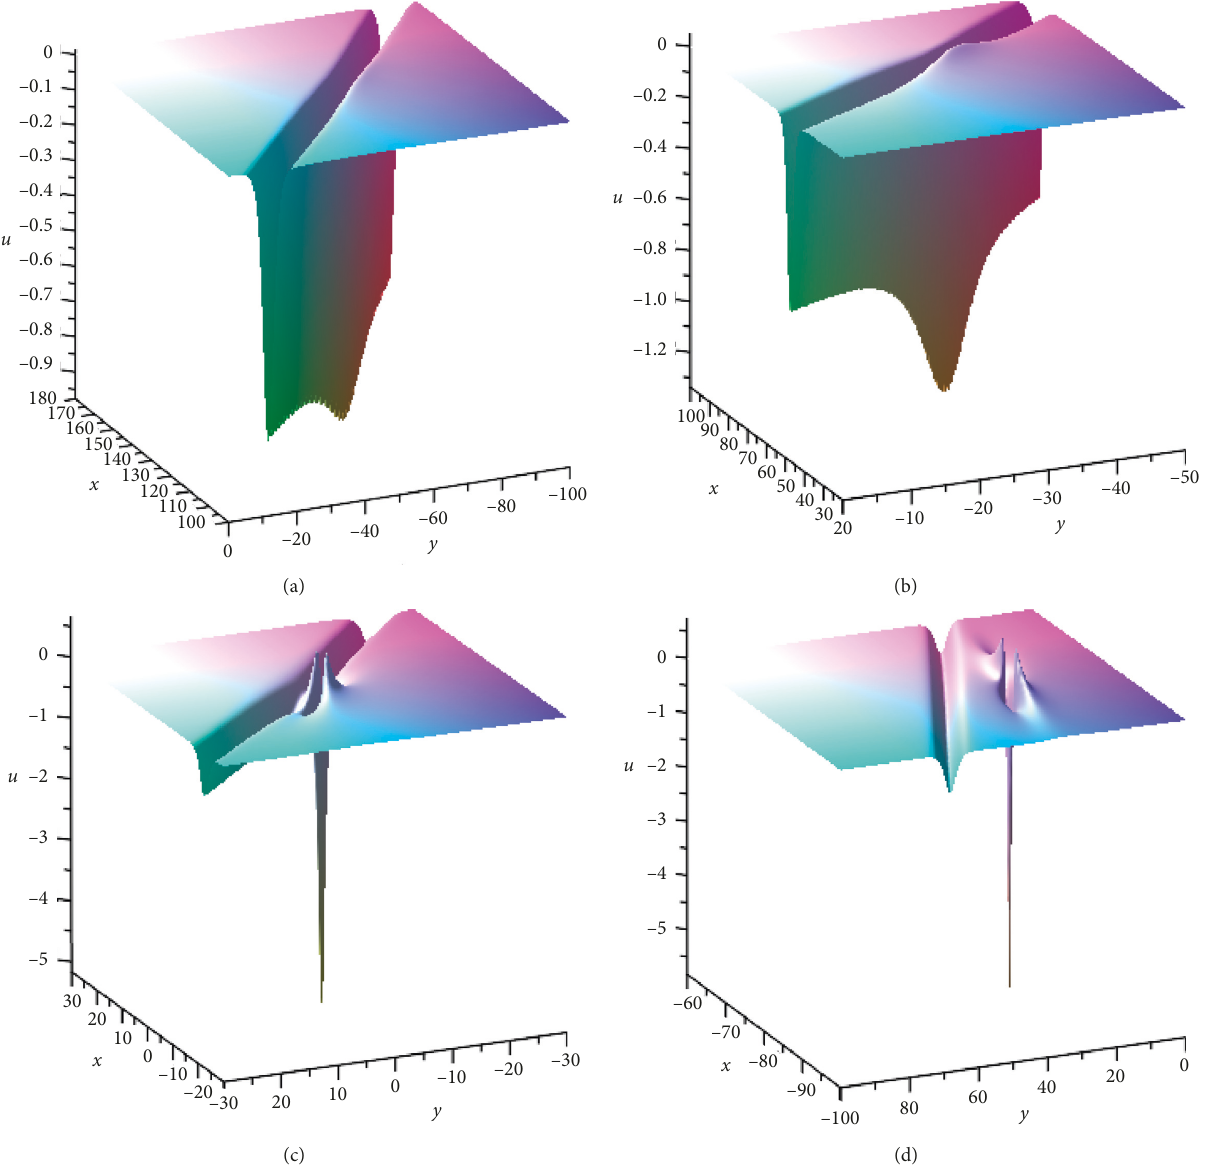
Figure 3: The three-dimensional structure of solution (25) with z � 0 and different time: (a) t � − 40; (b) t � − 20; (c) t � 0; (d) t �